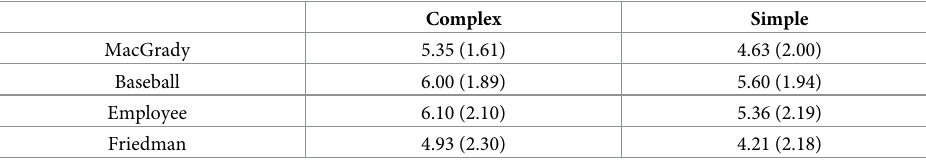
Statistics represent mean(standard